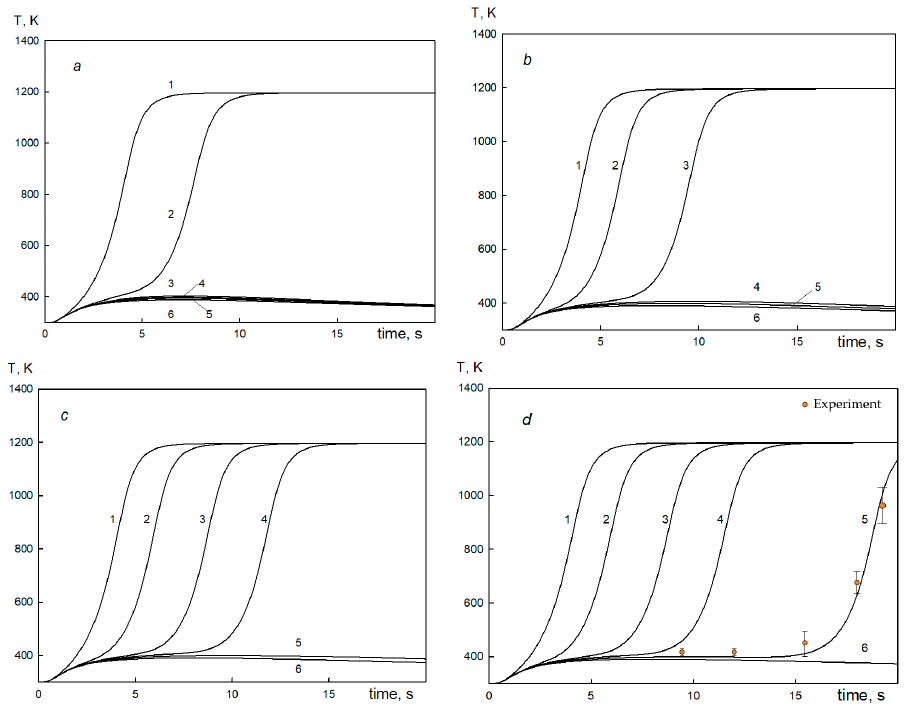
Figure 14. Temperature change at a control point over time: 𝐿 = 70 mm, 𝐻 = 5 mm, 𝐷 = 5 mm, ( а ): 2 firebrands; ( b ): 3 firebrands; ( c ): 4 firebrands; ( d ): 5 firebrands ( 1 – 𝑙 = 0 ,2 – 𝑙 = 15 mm, 3 – 𝑙 = 20 mm, 4 – 𝑙 = 25 mm, 5 – 𝑙 = 30 mm, 6 – 𝑙 = 35 mm).